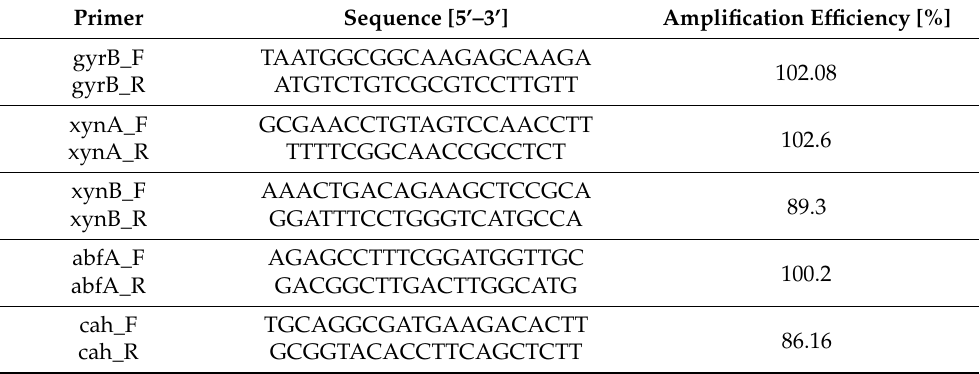
Table 1. Gene specific primer sequences and amplification